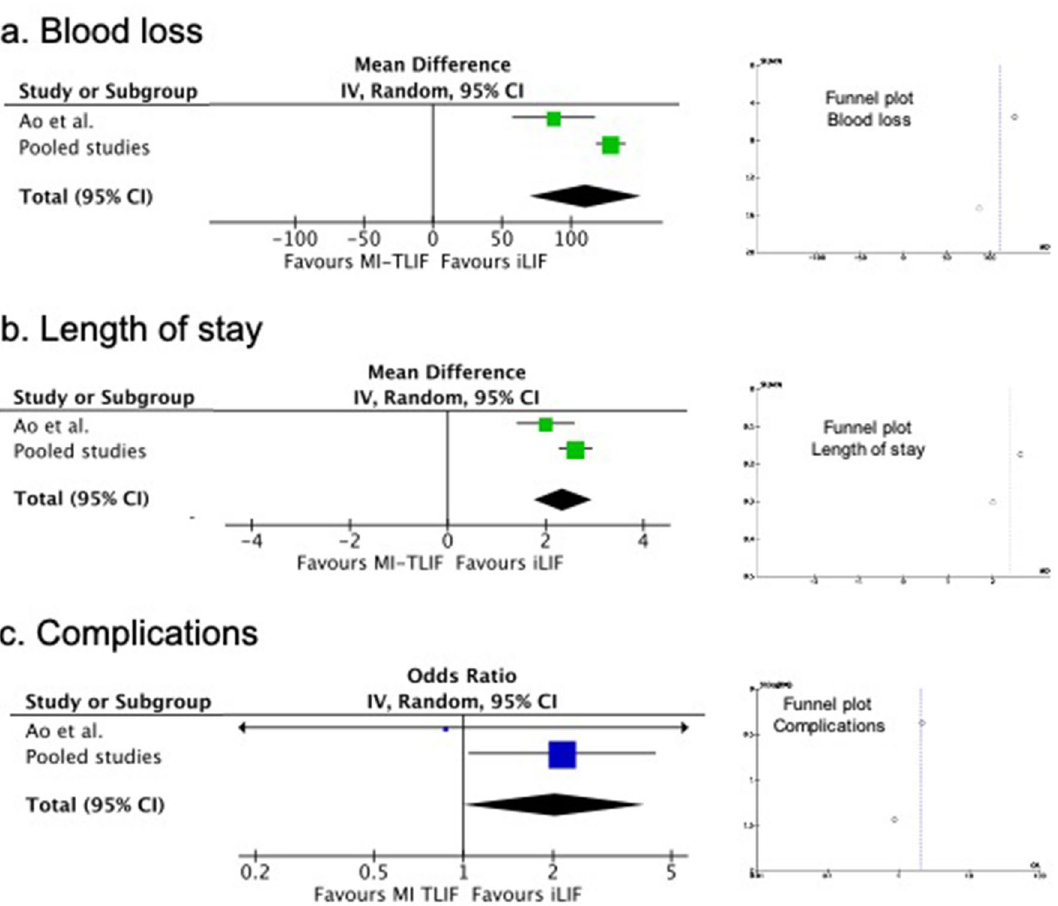
Figure 2. Comparison of blood loss ( a ), length of stay ( b ) and complications ( c ).